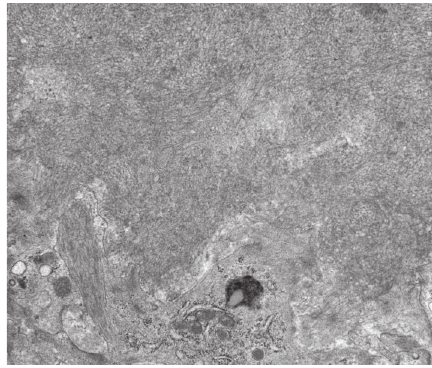
Figure 2: Electron microscopy. Showing deposition of small, ran- domly arranged fibrils in the mesangium with features characteristic of amyloid